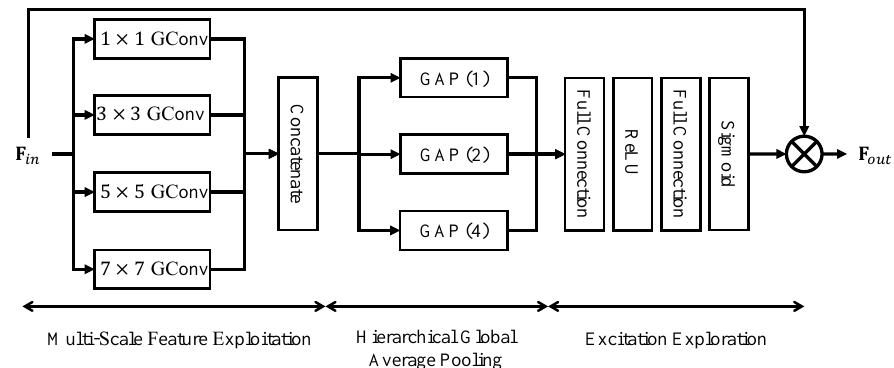
Figure 1. Structure of proposed hierarchical global attention mechanism (HGA). There are three modules in our proposed HGA: Multi-Scale Feature Exploitation (MFE), Hierarchical Global Average Pooling (HAP), and Excitation Exploration